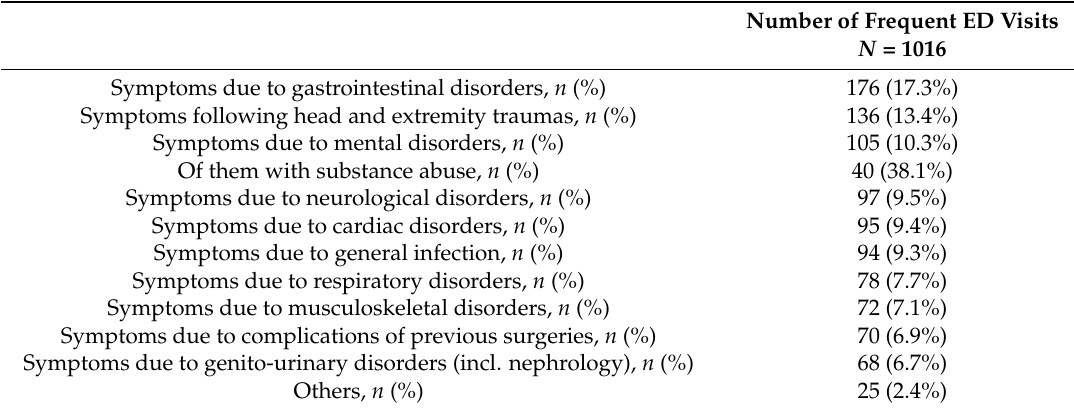
Table 5. Number of leading symptoms for frequent ED